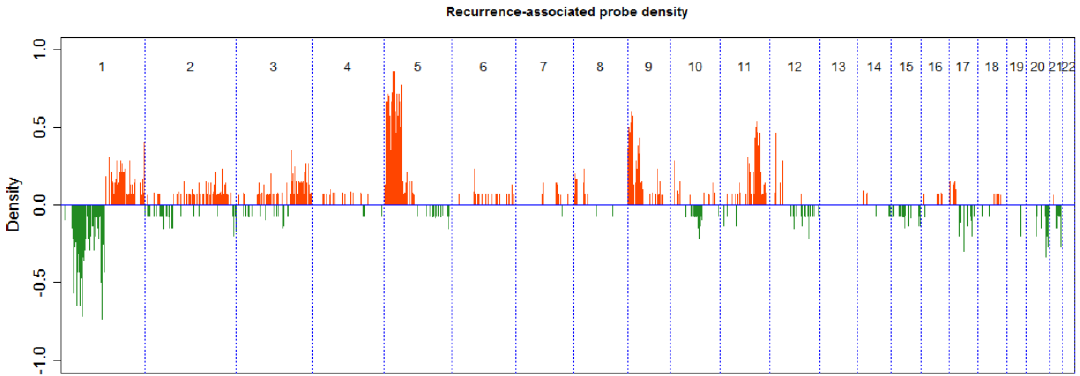
Figure 1. Frequency plots of DNA copy number aberrations in 8 patients without recurrence and 13 patients with recurrence.